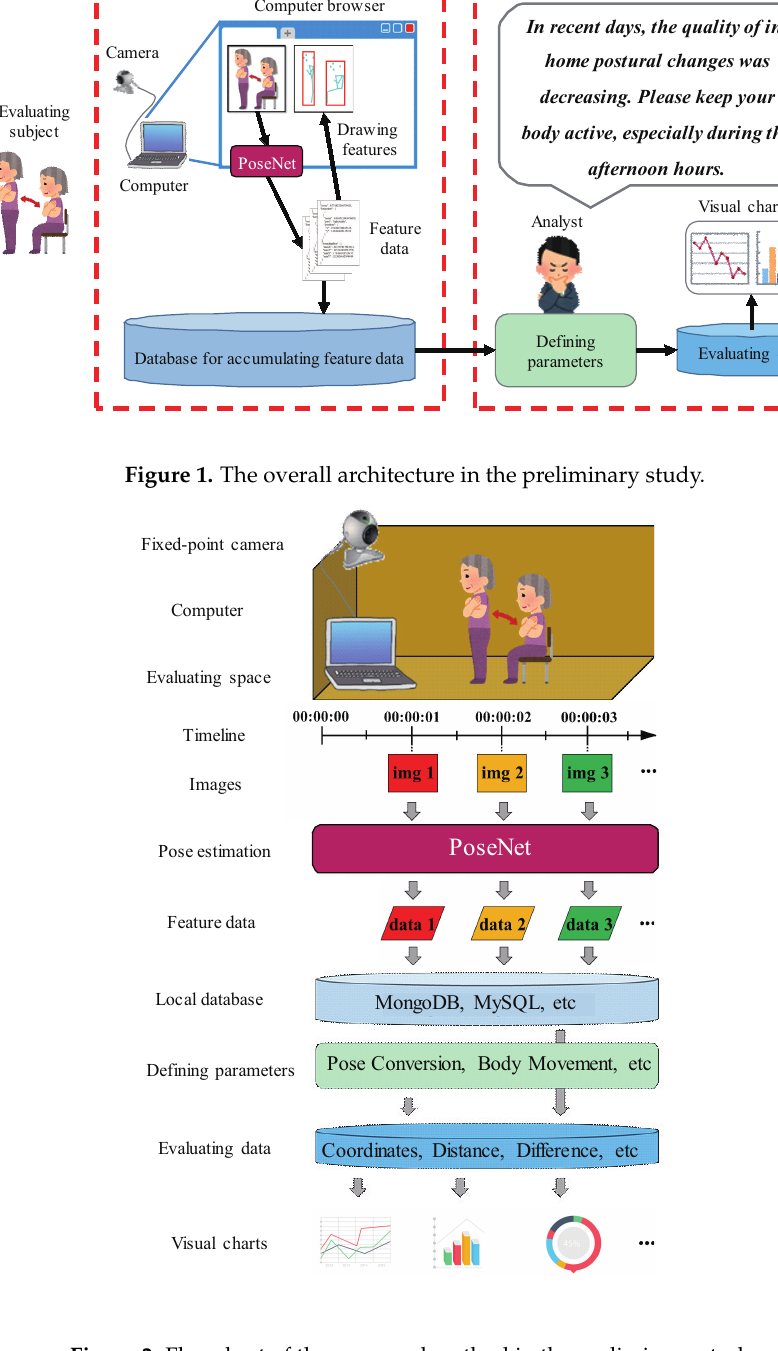
Figure 2. Flowchart of the proposed method in the preliminary